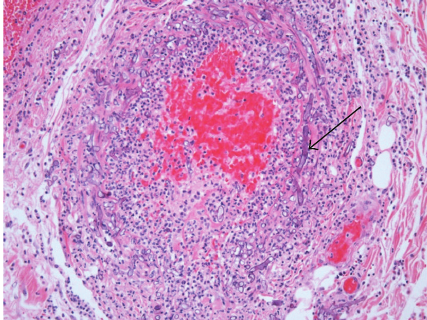
Figure 4: Pathological examination (H&E stain) of the colon showed di ff use active and chronic inflammatory infiltrate with extensive necrosis; broad nonseptate hyphae with irregular branch- ing typical of mucormycosis are present (arrow) within this infiltrate and invade blood vessel